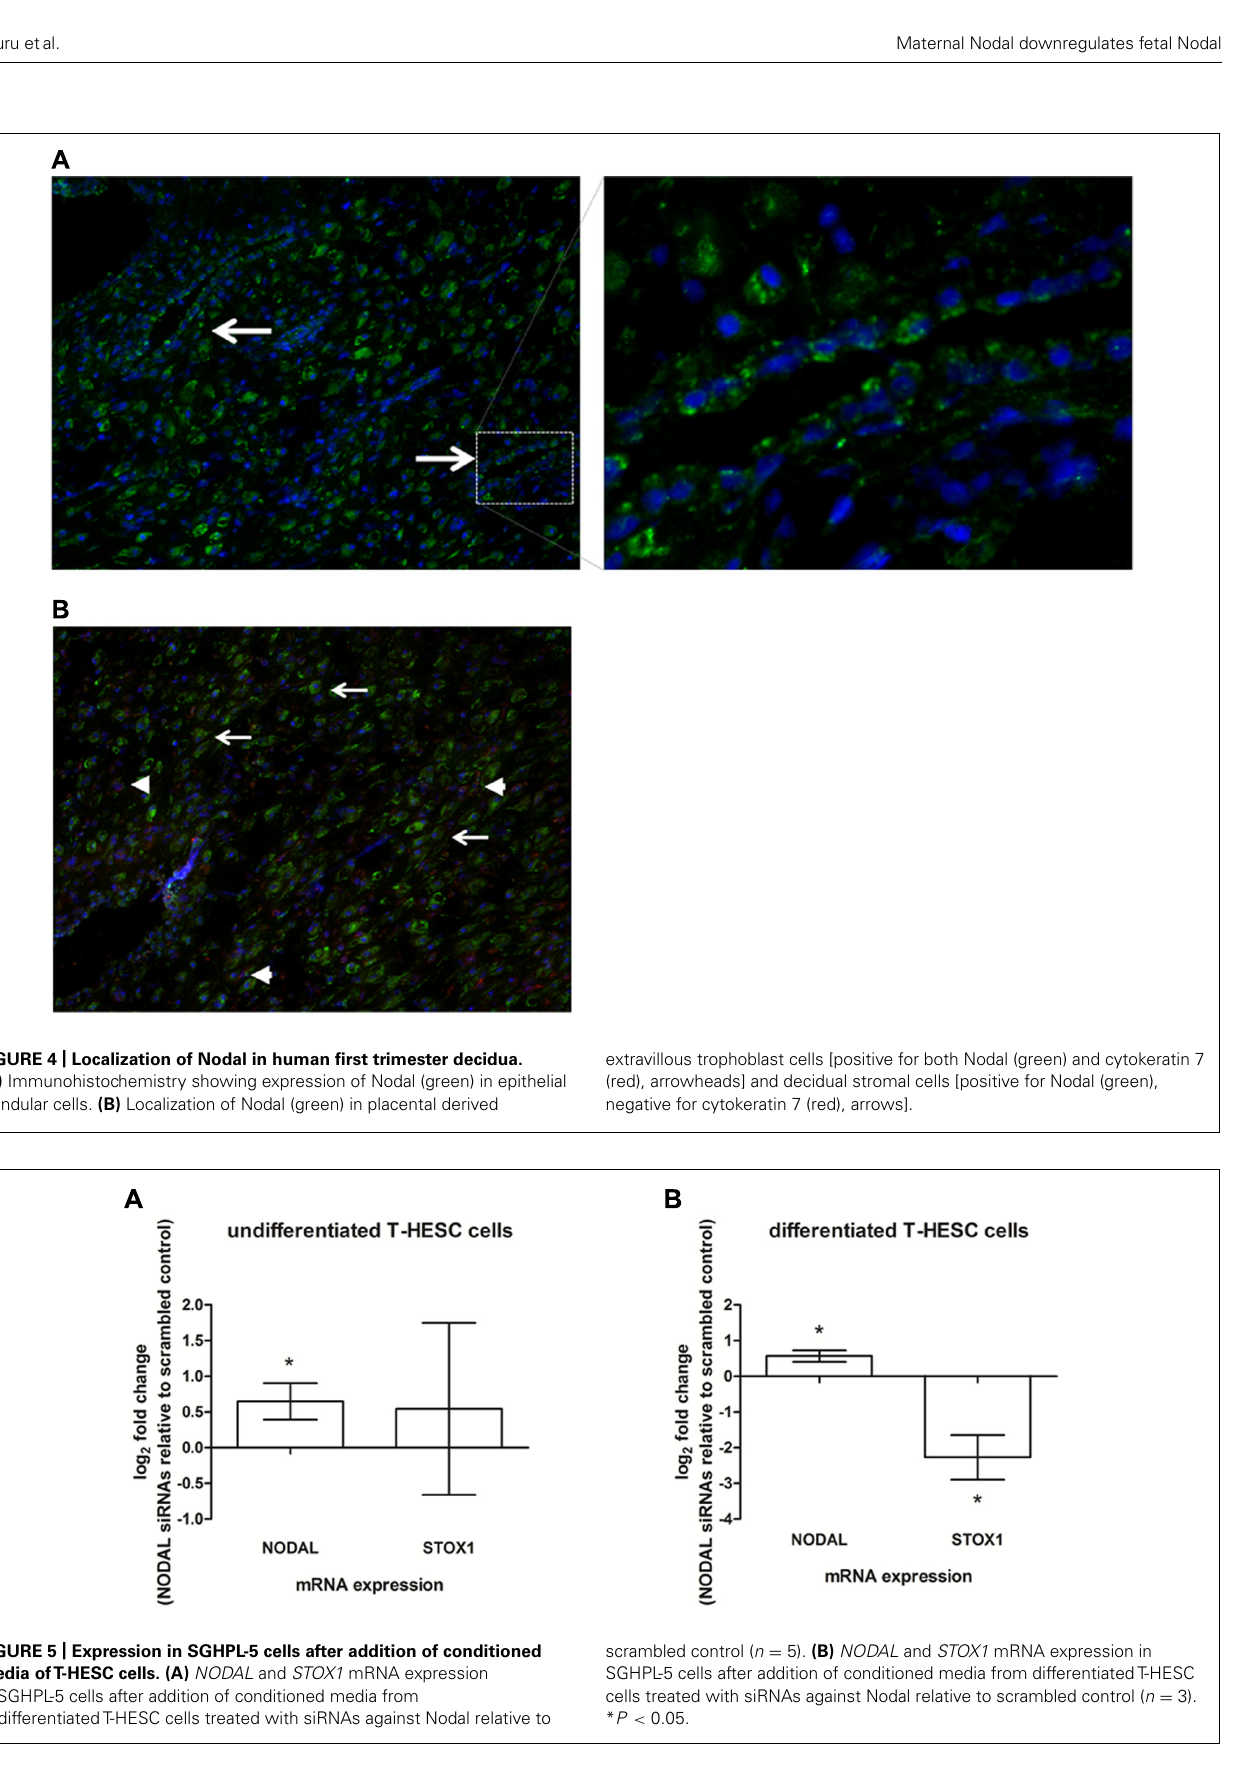
FIGURE 5 | Expression in SGHPL-5 cells after addition of conditioned media ofT-HESC cells. (A) NODAL and STOX1 mRNA expression in SGHPL-5 cells after addition of conditioned media from undifferentiatedT-HESC cells treated with siRNAs against Nodal relative to